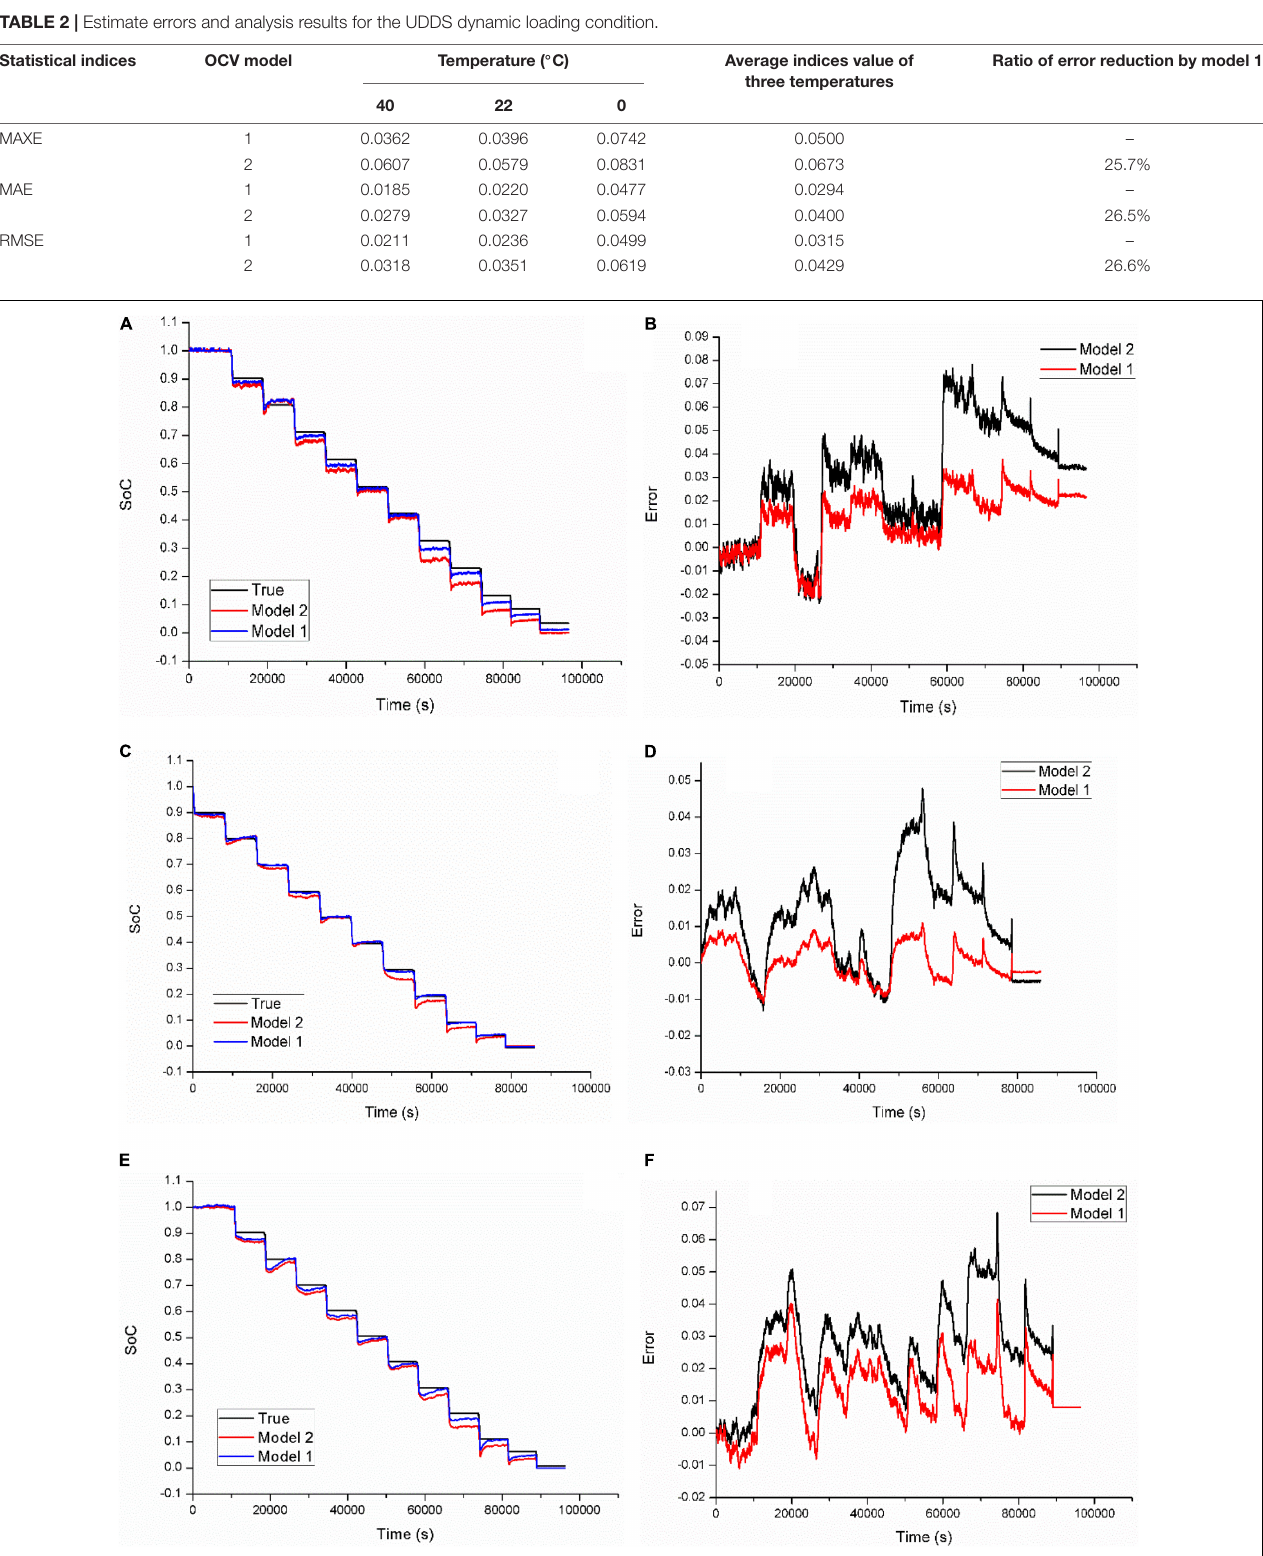
FIGURE 8 | Estimation results based on model 1 and model 2 at three temperatures via the HPPC. (A) Estimated SoCs at 40 ◦ C; (B) estimation errors at 40 ◦ C; (C) estimated SoCs at 22 ◦ C; (D) estimation errors at 22 ◦ C; (E) estimated SoCs at 0 ◦ C; (F) estimation errors at 0 ◦ C.